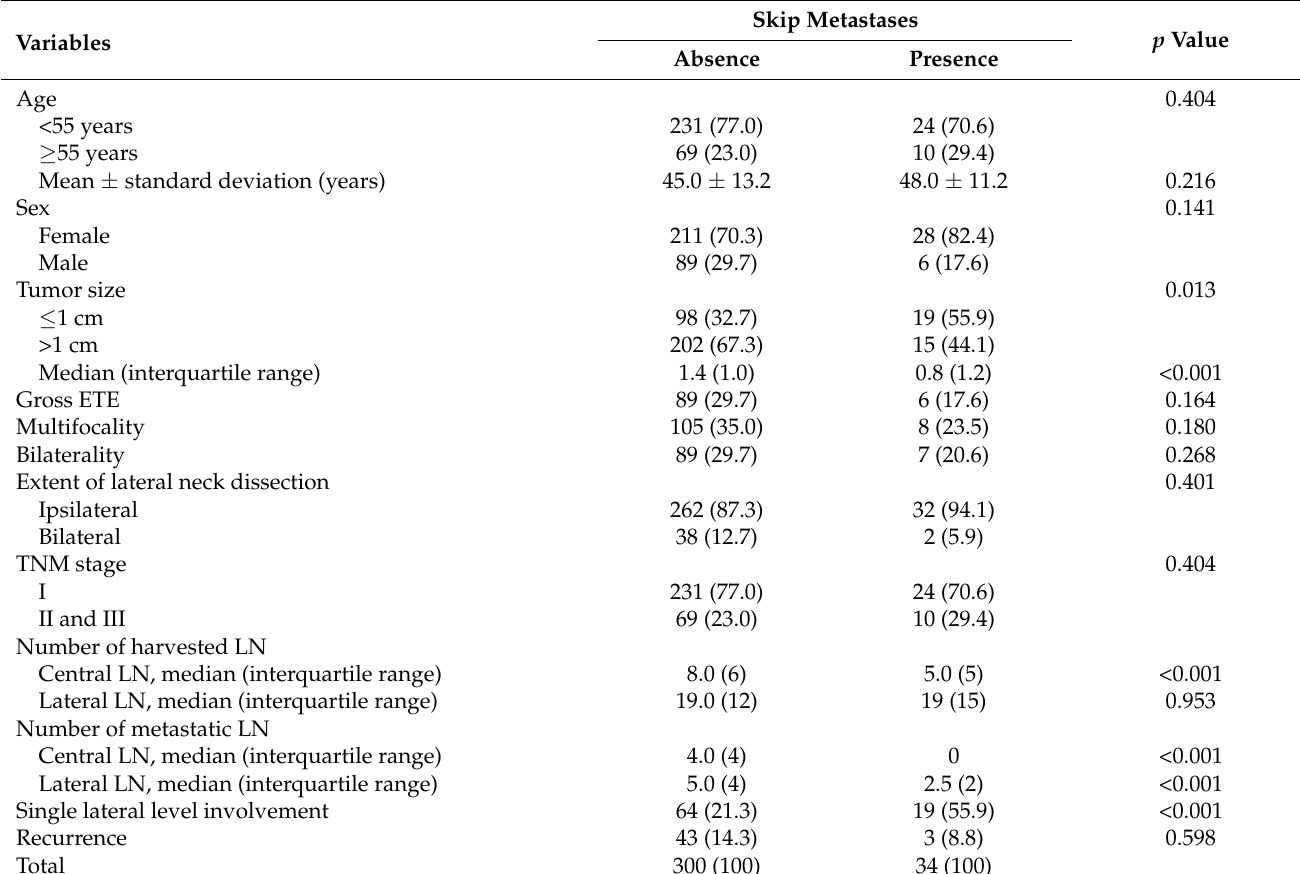
Table 2. Comparison of patients with and without skip metastases.